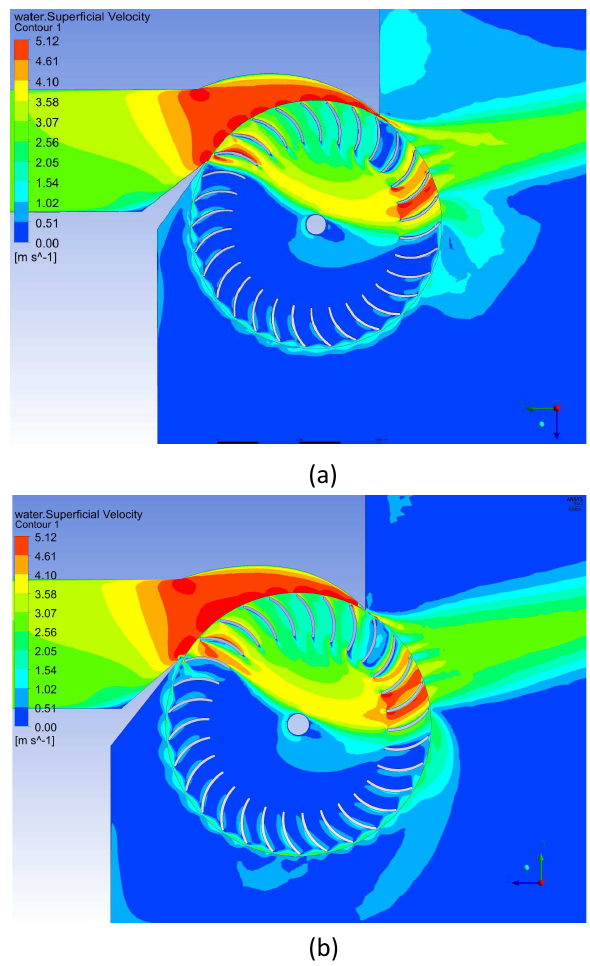
Figure 6. Contour plot of the magnitude of mean water velocity for the 0.53 kW turbine at maximum efficiency ( H = 1.337 m, Q = 46 lps and N = 199.1 RPM). ( a ) the original nozzle with a circular profile; and ( b ) the new nozzle shape given by Equation (3).